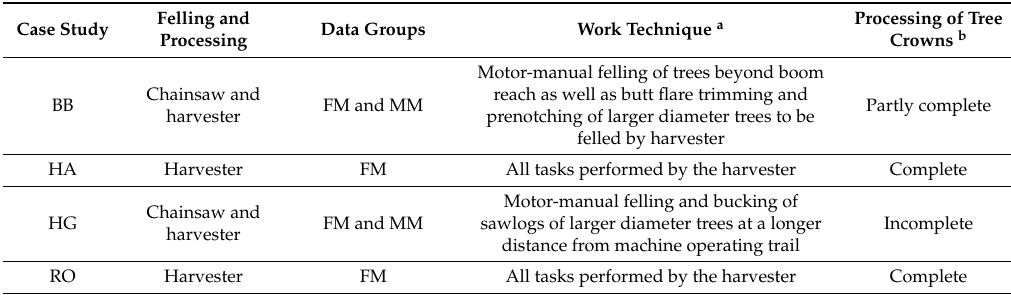
Table 3. Description of the four case studies.